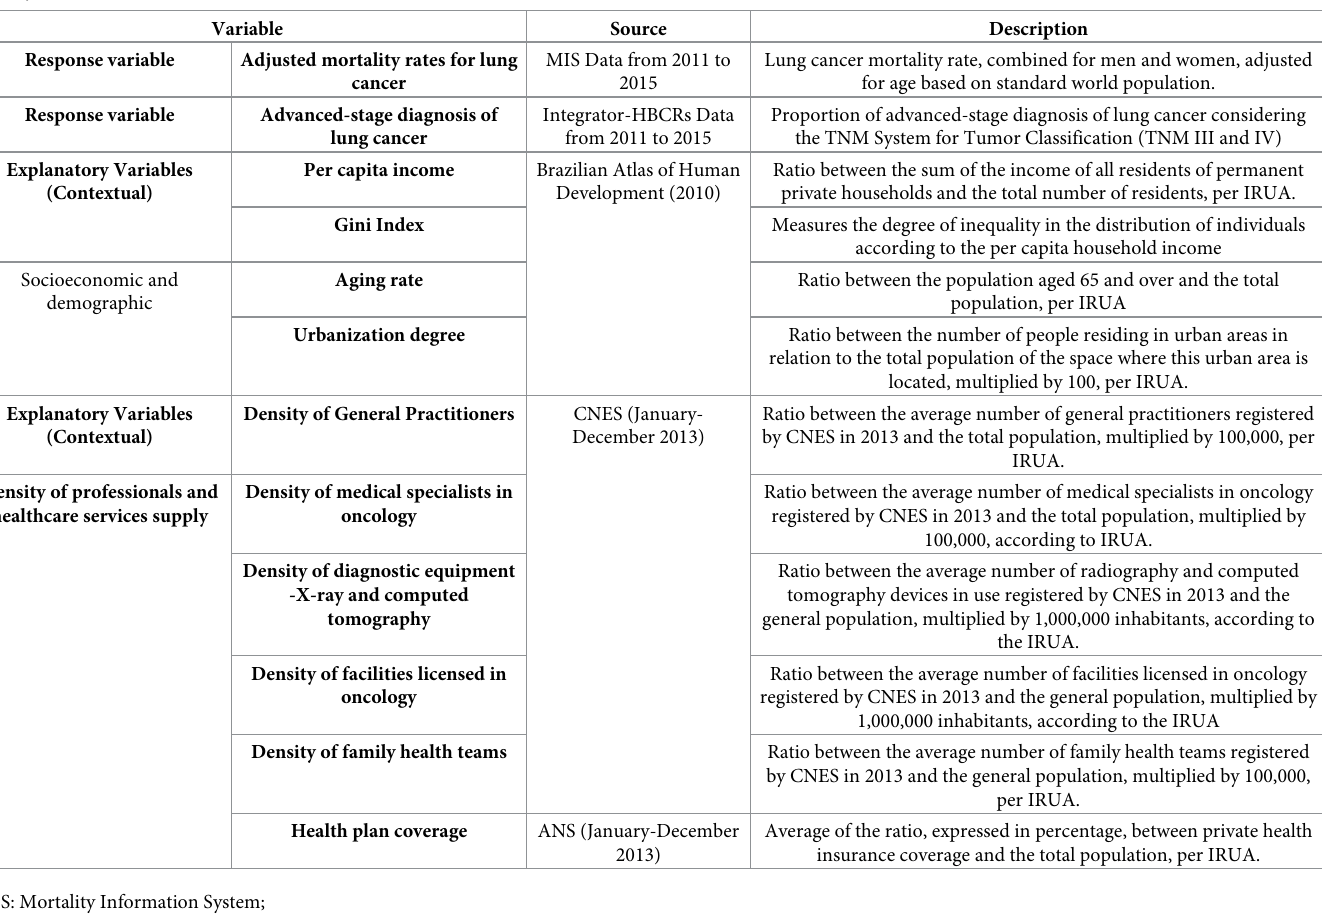
Table 1. Characteristics and details of response variables and explanatory variables for spatial analysis of mortality and advanced-stage diagnosis of lung cancer in Brazil,